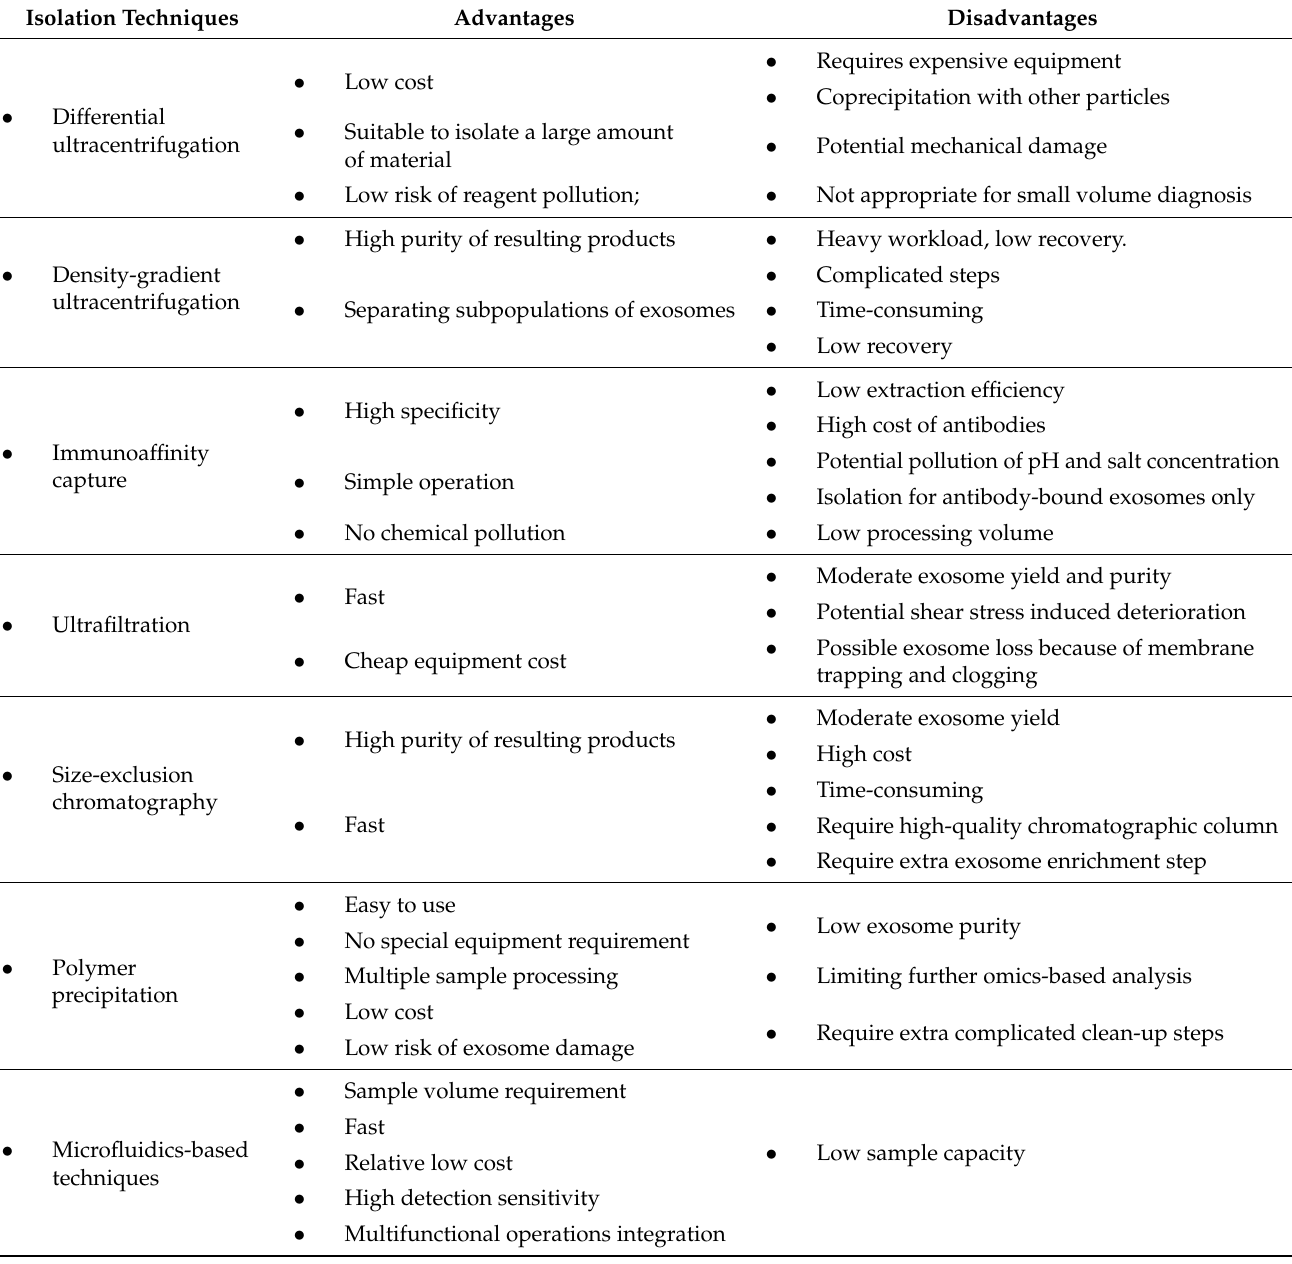
Table 5. Summary of advantages and disadvantages of exosome isolation